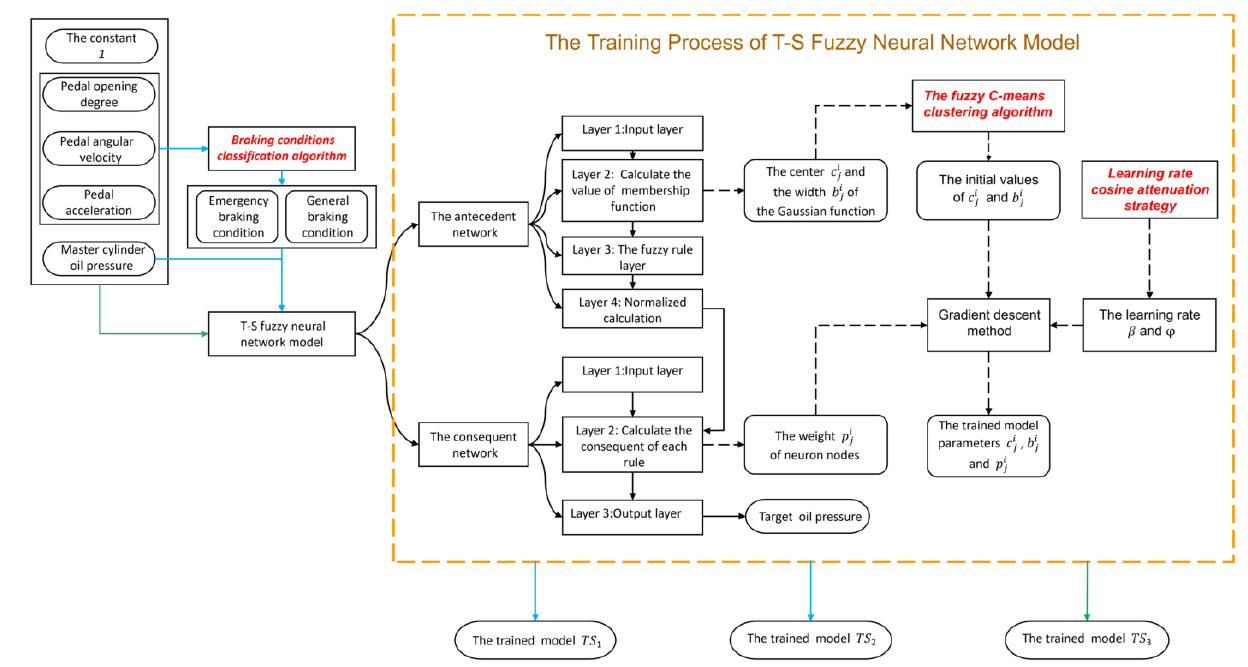
Figure 11. The training process of the target oil pressure recognition model.